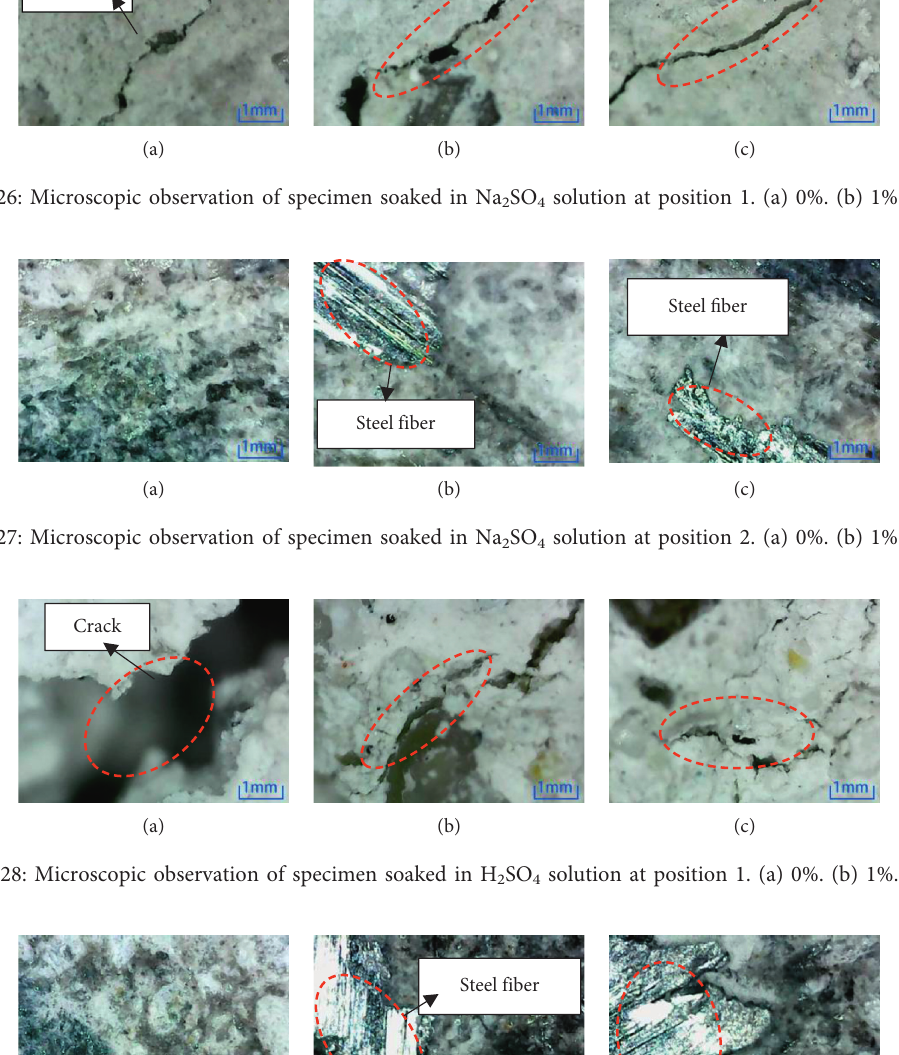
2 SO 4 solution at position 2. (a) 0%. (b) 1%. (c) 2%.